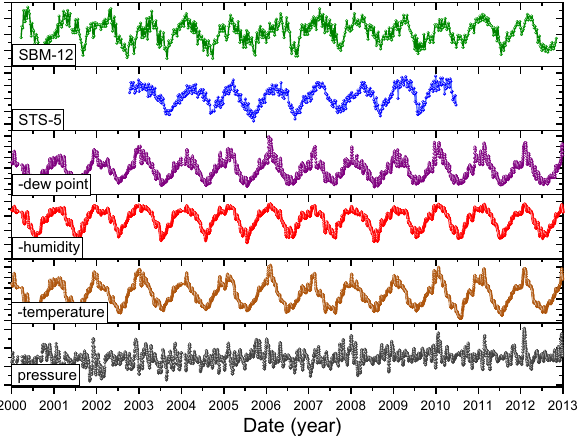
Figure 3. The shape of the variations in the 90 Sr/ 90 Y decay rates measured with the SBM-12 and STS-5 G–M counters by Parkhomov 5 , compared to historical weather data in Moscow 35 . The dew point, humidity and temperature data are presented in reverse scale for direct comparison with the decay